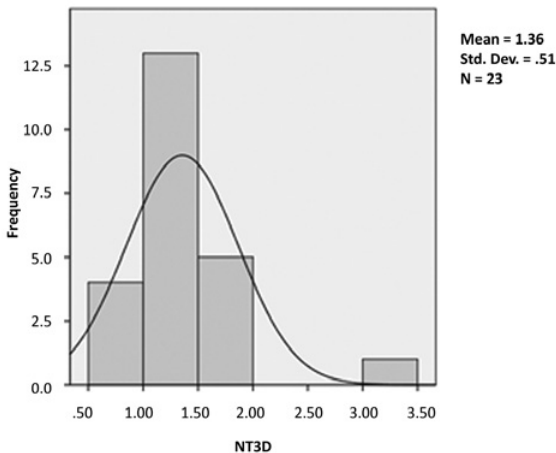
Fig. 6 - Matric scatter plot for three trials 2D ultrasonic NT measurement (Sample Size N = 23).